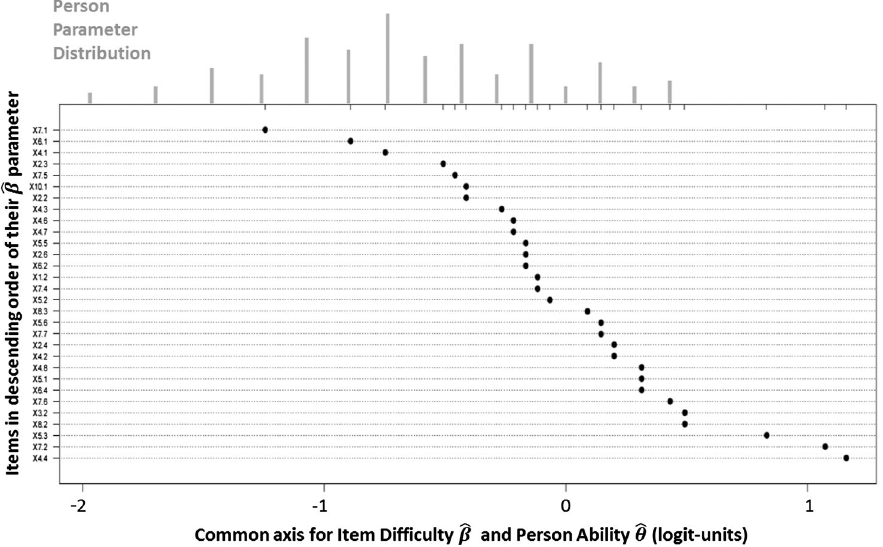
FIG. 6. Person-Item map for PSCI-ALPHA. The black dots represent item locations. Each black dot corresponds to a tick on the upper ˆ θ horizontal axis. The gray bars at the top mark person locations ν on the common logit axis. The height of a gray bar is proportional to the number of persons at that location (histogram). The 19 persons repeating the test have two distinct estimated abilities, at pre- and postinstruction; therefore, a total of 64 þ 19 persons are depicted in the histogram person parameter distribution. The median ability is − 0 . 585 (cid:1) 0 . 391 logit, below the 0 logit of the test difficulty. The mode of the ability distribution is − 0 . 741 (cid:1) 0 . 399 logit.